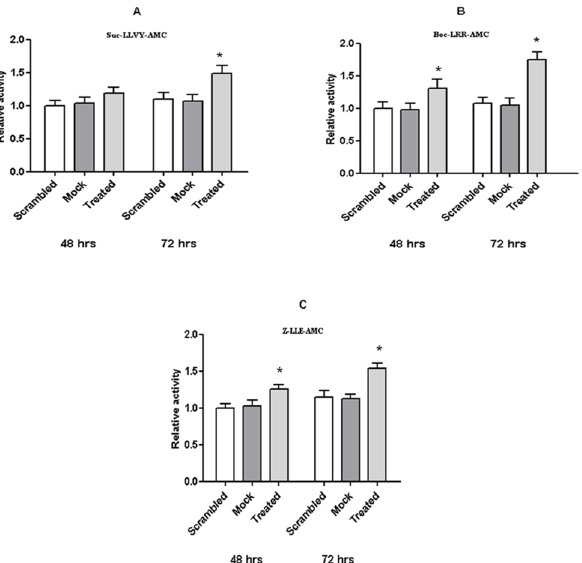
Fig 2. 26S proteasome activity in crude cell extracts from treated and wild-type SHSY5Y. The proteasome assay on crude cell extracts from either treated or wild-type cells was performed 48 h and 72 h after the anti-sense oligonucleotide delivery. The chymotryptic-like (A), the tryptic-like (B) and the caspase- like (C) activities of the 26S proteasome particles were assayed on specific fluorogenic substrates. Values reported are the means +/- S.E. of five independent experiments. * , significantly different from control ( p < 0.05, one way ANOVA, followed by Tukey ’ s test, n =